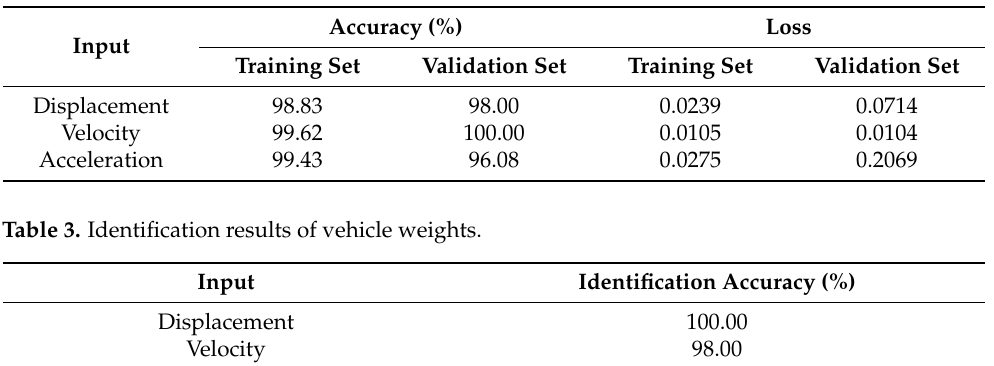
Figure 8. Results of vehicle weights identification: ( a ) Training accuracy curves of response samples; ( b ) Training loss curves of the response samples; ( c ) Validation accuracy curves of the response samples; ( d ) Validation loss curves of response samples. Table 2. Train results of vehicle weights identification after 50 epochs.